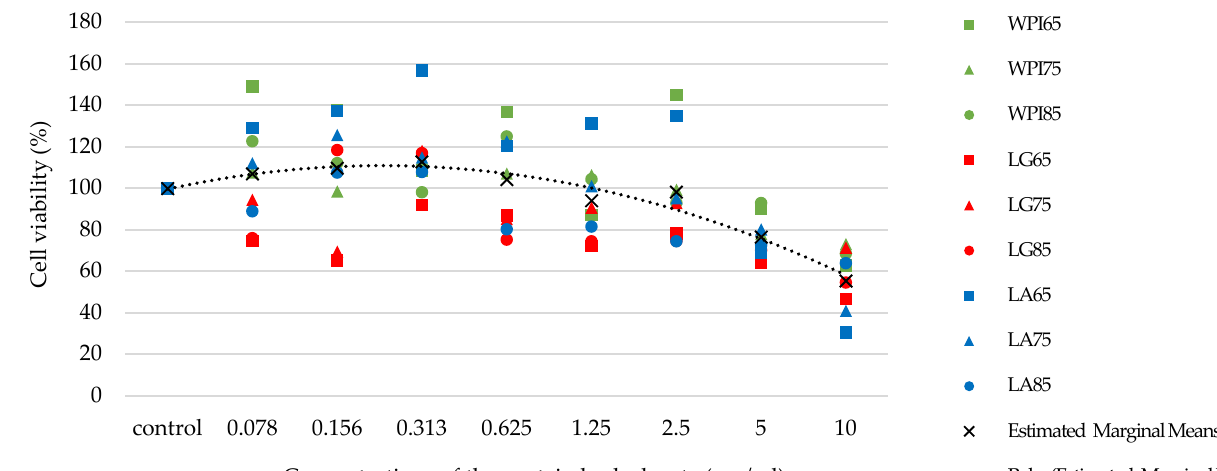
Figure 2. Cell viability (%) of the human salivary gland (HSG) cells after 24 h incubation with DMEM (control) and the protein hydrolysate at concentrations between 0.078 and 10 mg/mL ( n = 4). WPI, LG, and LA denote whey protein isolate, β -lactoglobulin, and α -lactalbumin solutions, respec- tively. The number after the abbreviated protein solutions indicates the temperature (°C) of the heat treatment process.